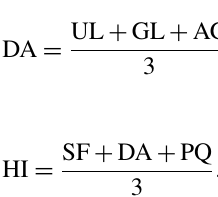
Flexible barriers <